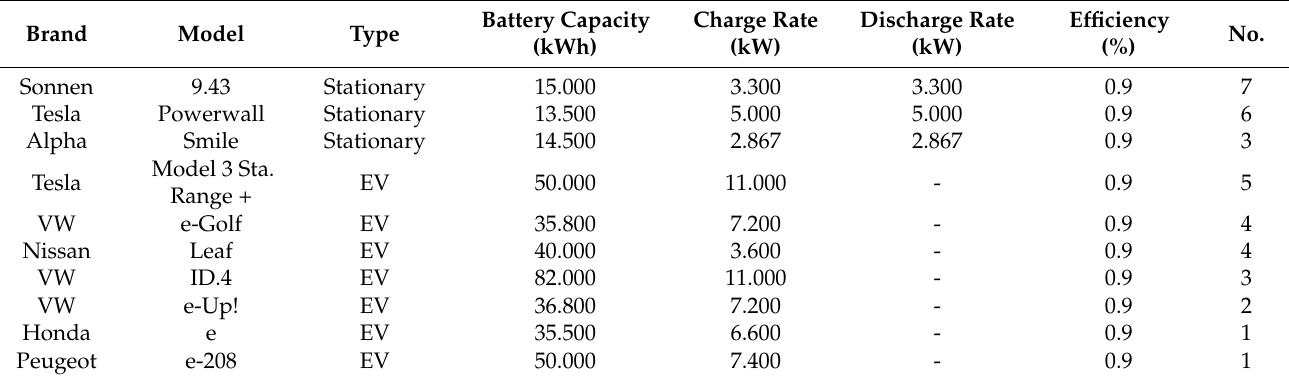
Table 1. Stationary and electrical vehicle (EV) battery